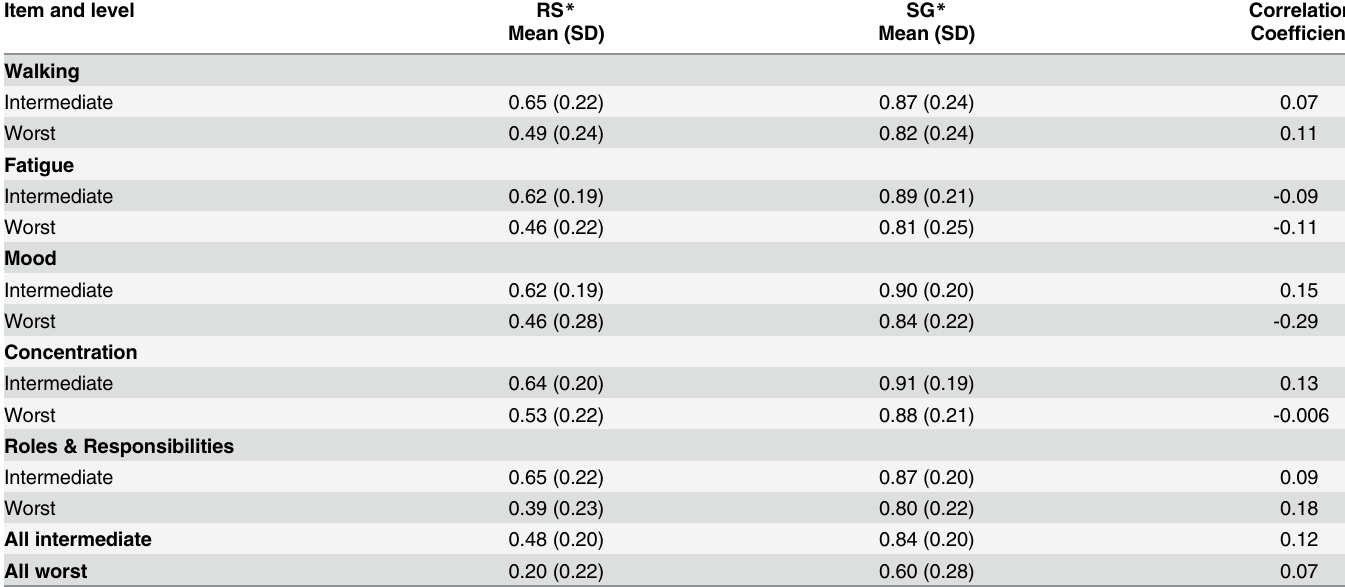
Table 3. Mean rating scale and standard gamble values derived from the development